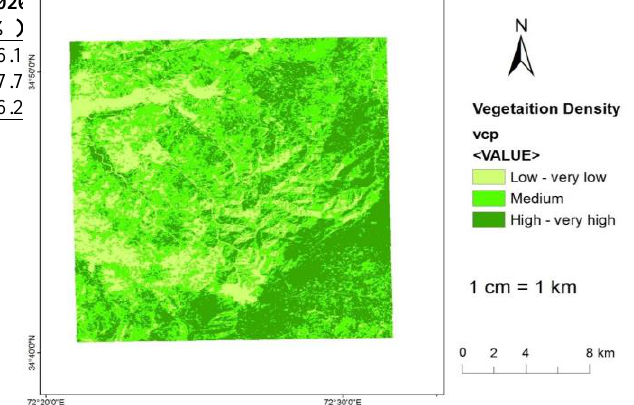
Figure 6: Distribution of vegetation cover based on VCP in the